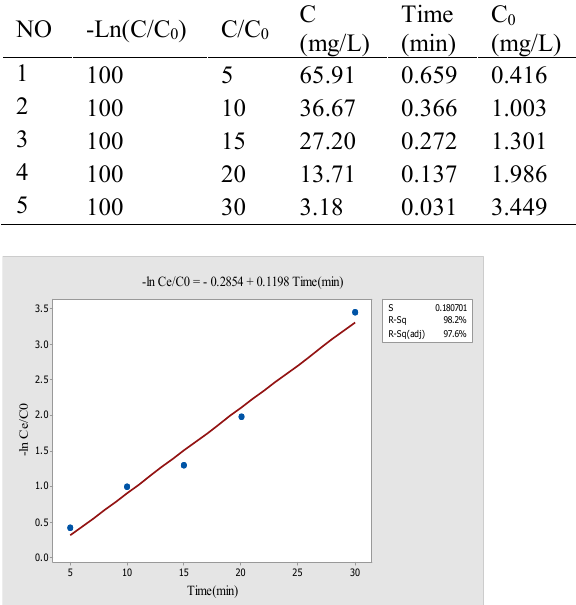
Fig. 11. First-order reaction kinetics for removal of acid blue 113 dye